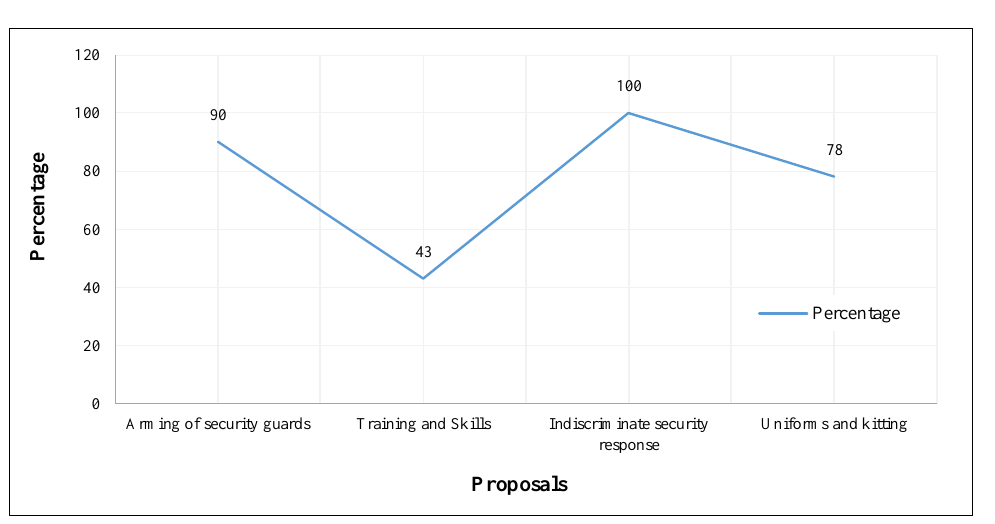
Figure 3. General public